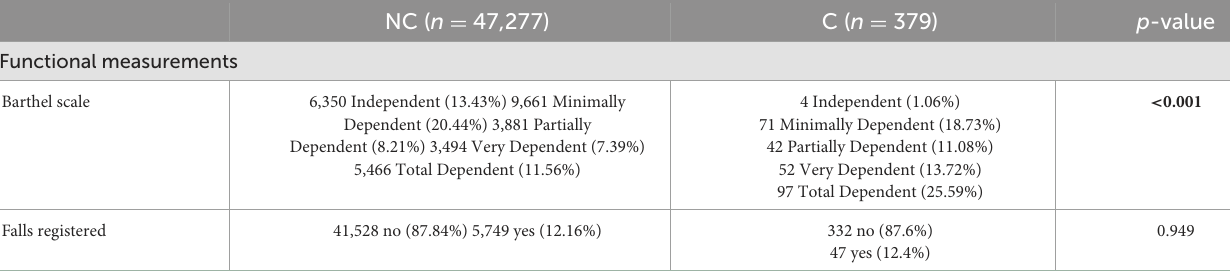
TABLE 5 Functional measurements for centenarians and non-centenarians.